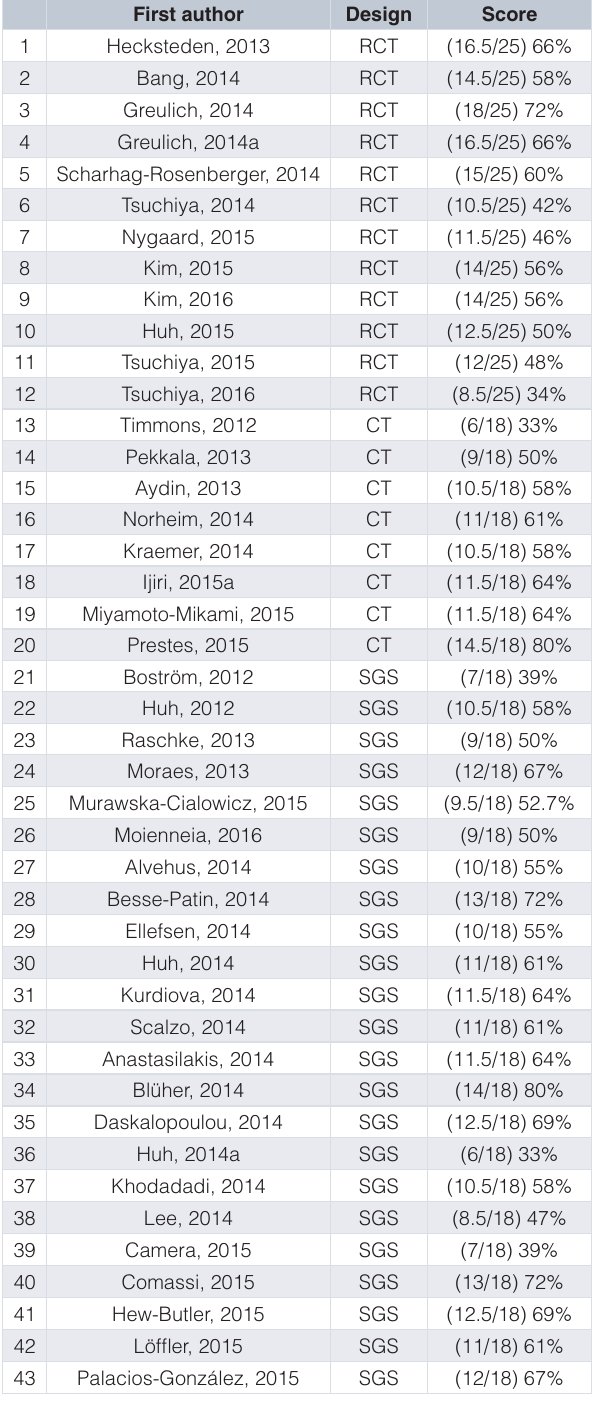
Table 3. Quality of the reporting of the results using the CONSORT checklist. Score represents the number of items (with percentage of items) on the checklist that were reported satisfactorily in each study. Therefore, a high score represents a high adherence to reporting guidelines, while a low score represents low adherence to reporting